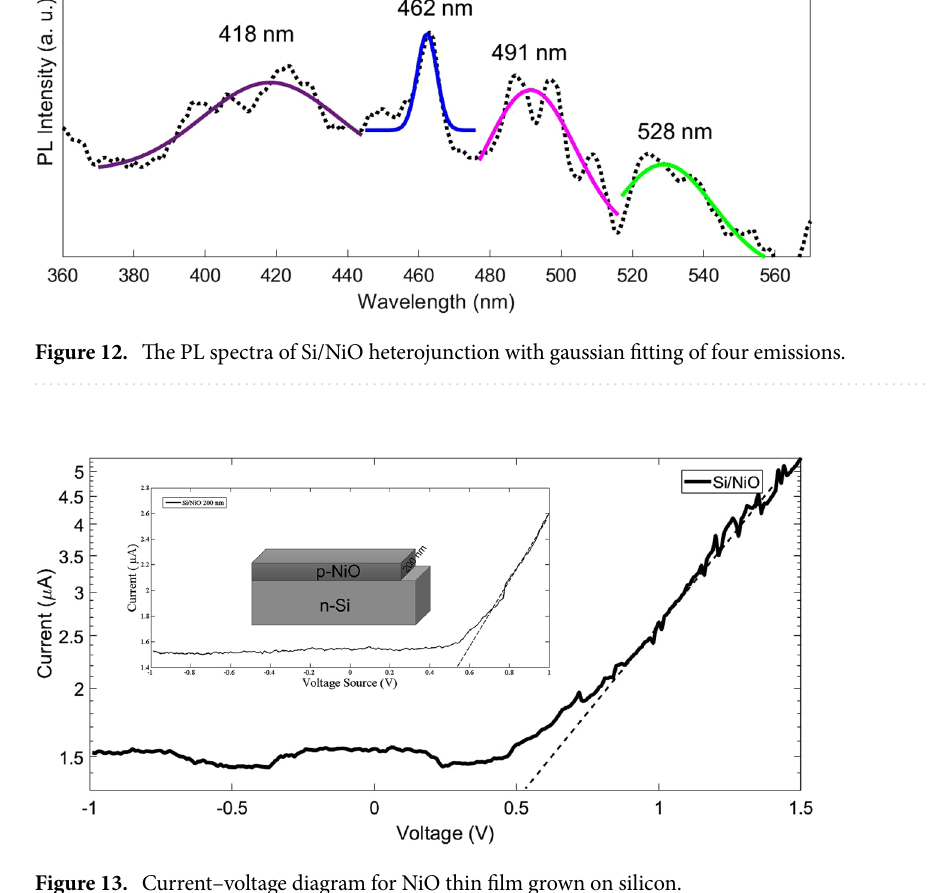
Figure 13. Current–voltage diagram for NiO thin film grown on